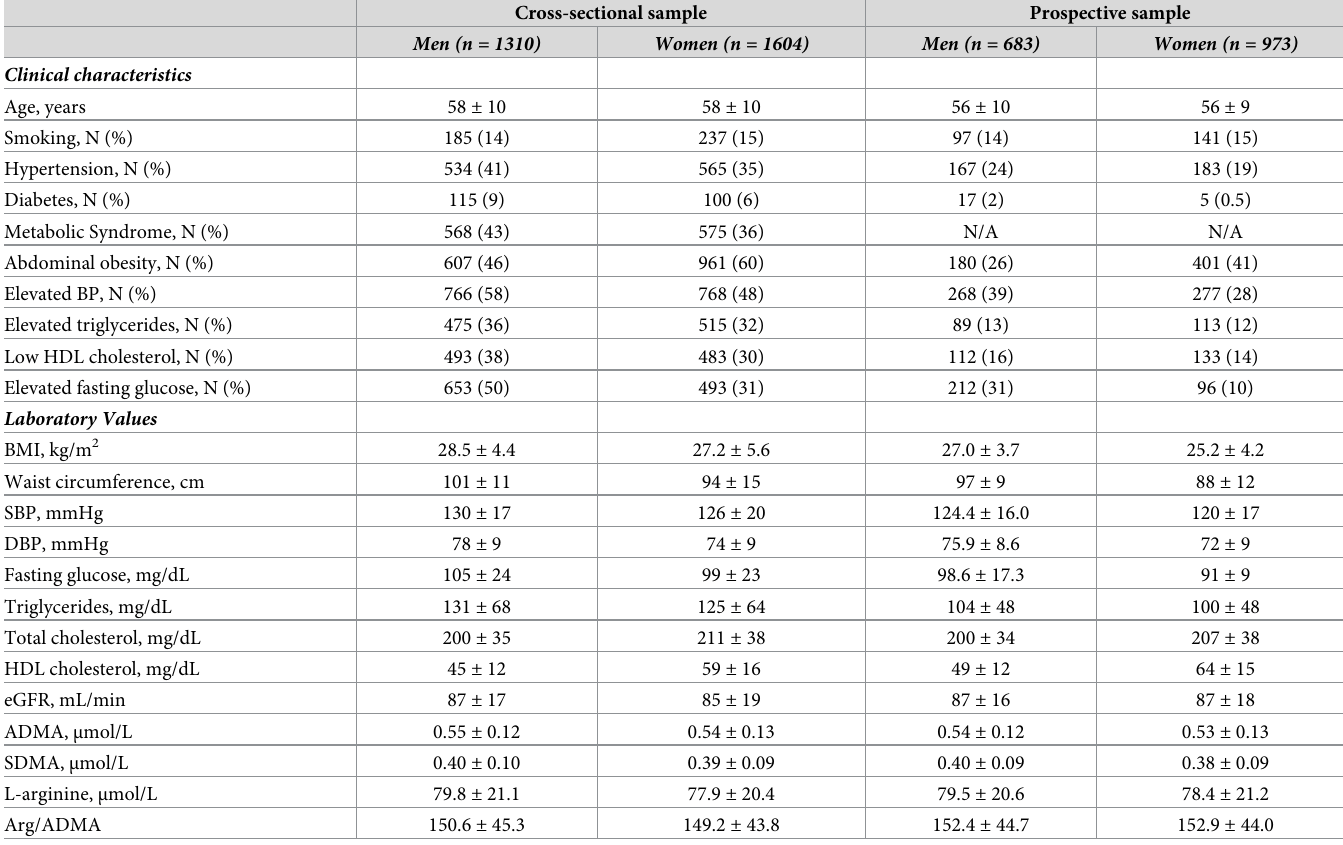
Table 1. Characteristics of study participants at the baseline examination for the cross-sectional and prospective analyses.